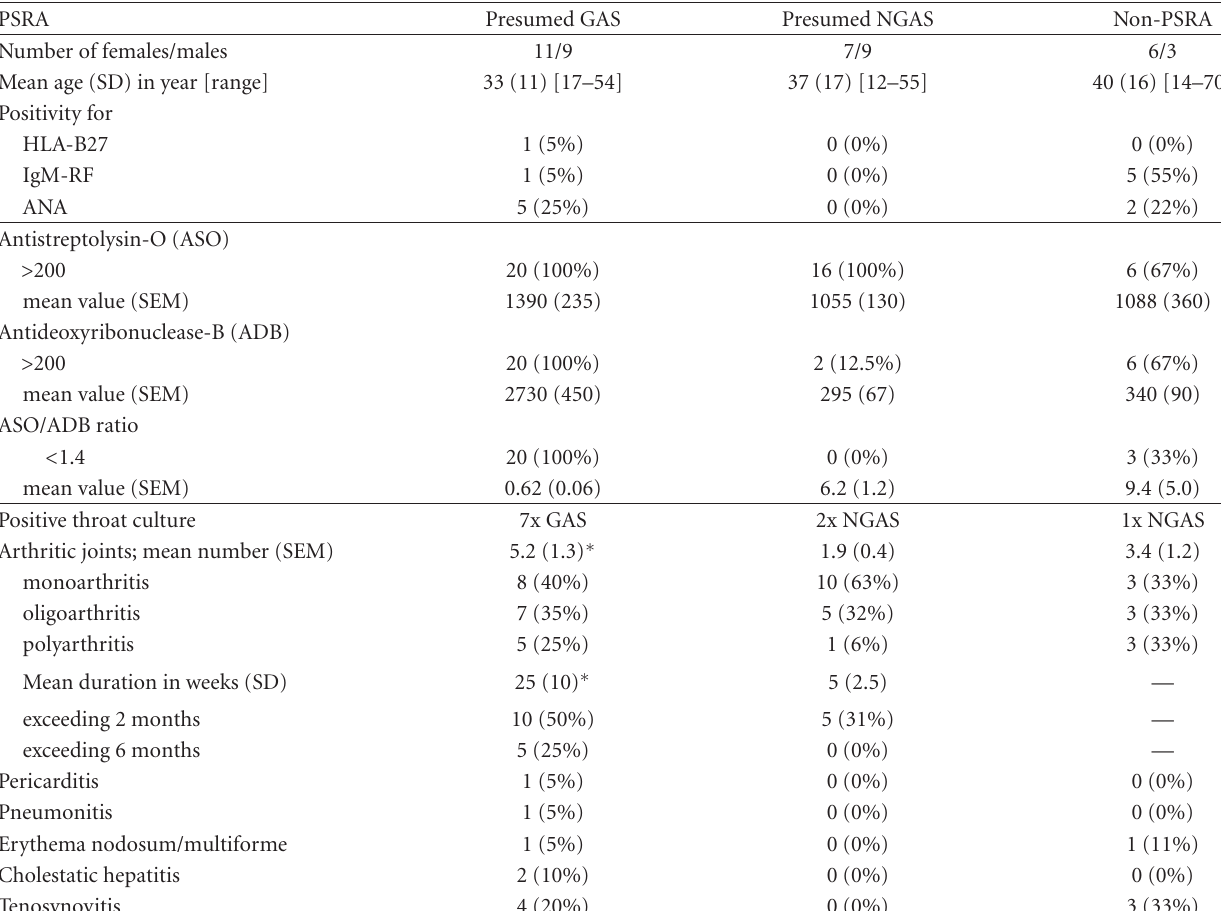
Table 1: Overview of 45 patients with acute arthritis subdivided into post-streptococcal reactive arthritis (PSRA) probably due to